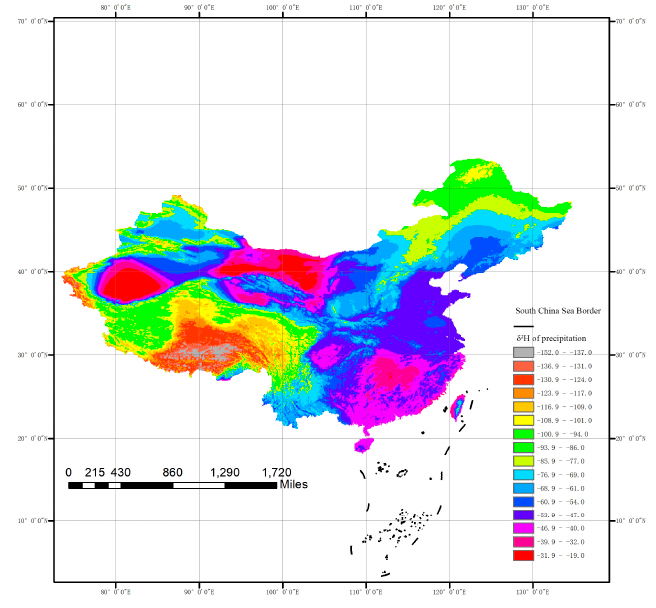
Figure 1. Zoning map of hydrogen stable isotopes during precipitation in mainland China.